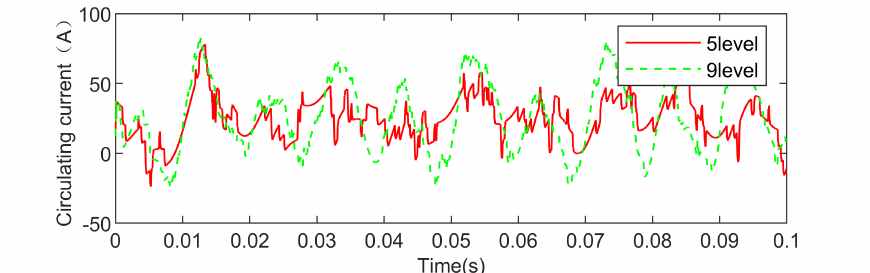
Figure 15. Circulating current ( i ca ) waveforms of two